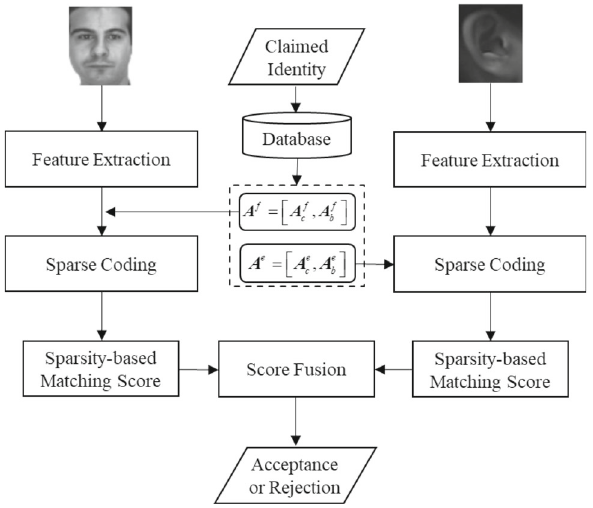
Fig. 8 Pipeline of a multimodal verification system using SRC Figure 9 plots the distributions of the multimodal SCE and SCR scores obtained on the MD I dataset. The over-